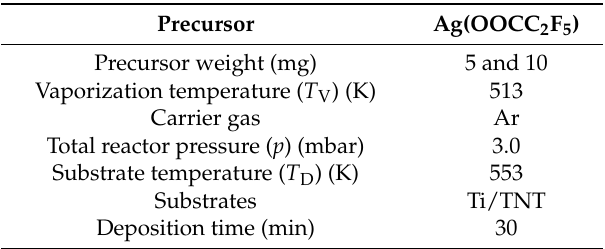
Table 3. Summary of CVD conditions for the deposition of silver